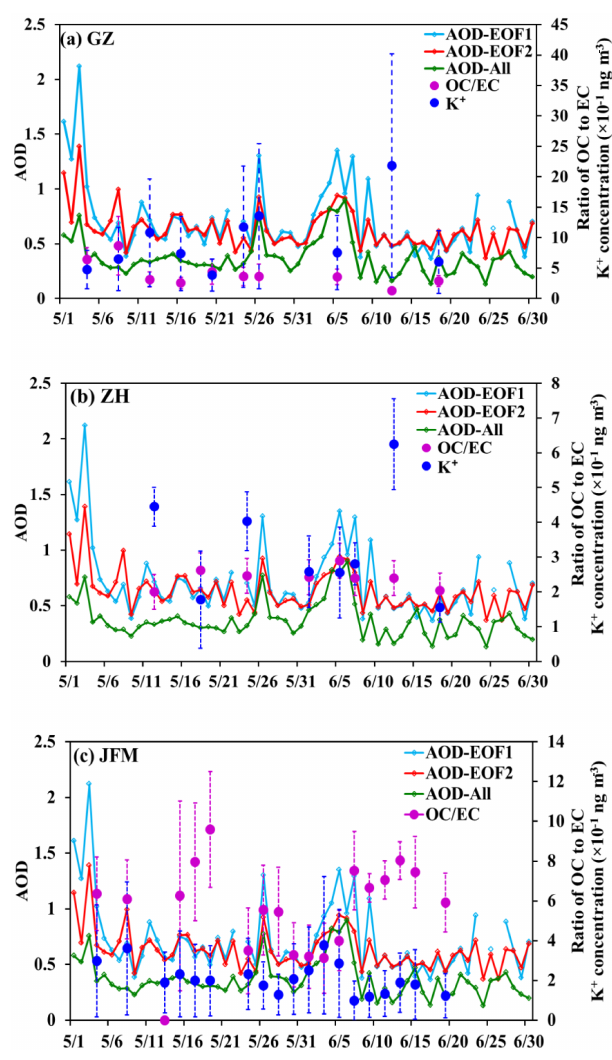
Figure 10. The time-varying statistics of the AOD averaged over the first two EOFs of the AOD (reflecting the regions most impacted by AOD variance or smoke from fires) and the average K + concentra- tion and average ratio of OC / EC in the three